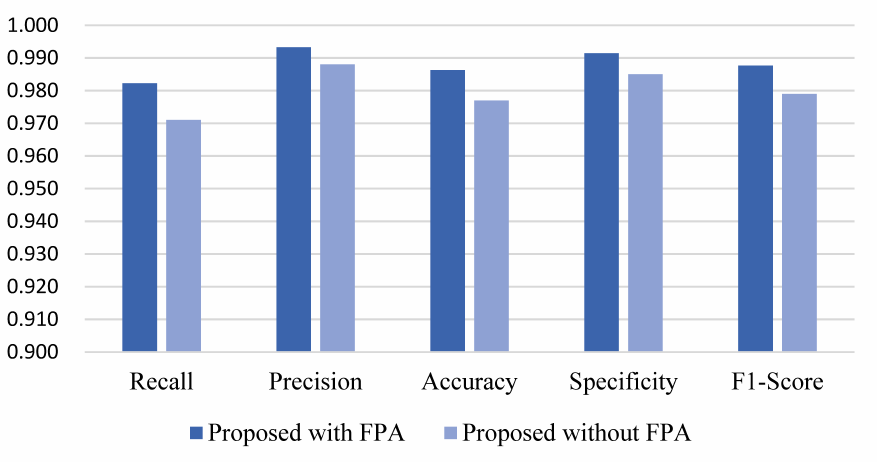
Figure 8. Classification performance comparison on FPA